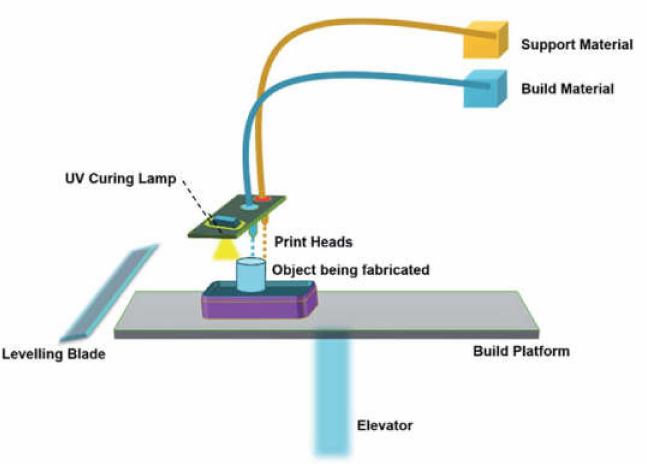
Figure 4. Schematics of the material jetting process [33]; published under the open access Creative Commons license with the Royal Society of